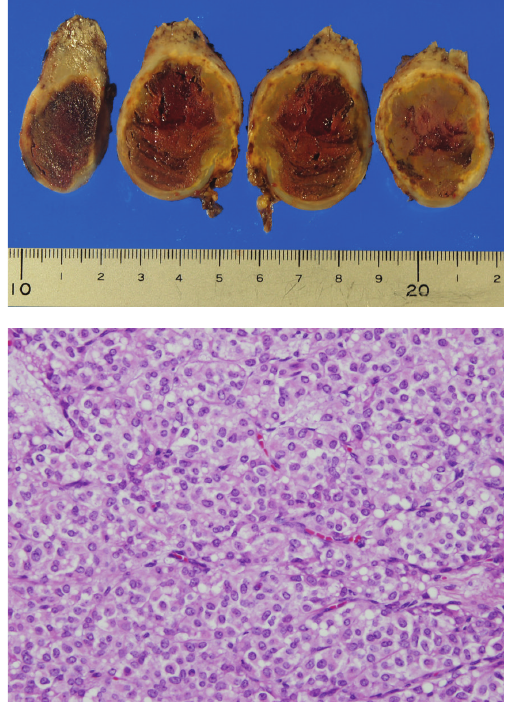
Figure 4: Resected specimen. Above: macroscopically, the tumor contained the necrosis after bleeding. However, there was no apparent cystic part in the tumor. Below (Hematoxylin and Eosin stain × 400): showing solid part of the tumor composed of sheet of tumor cells with ovoid nuclei and with eosinophilic and clear vacuolar cytoplasm. Mitosis was seldom